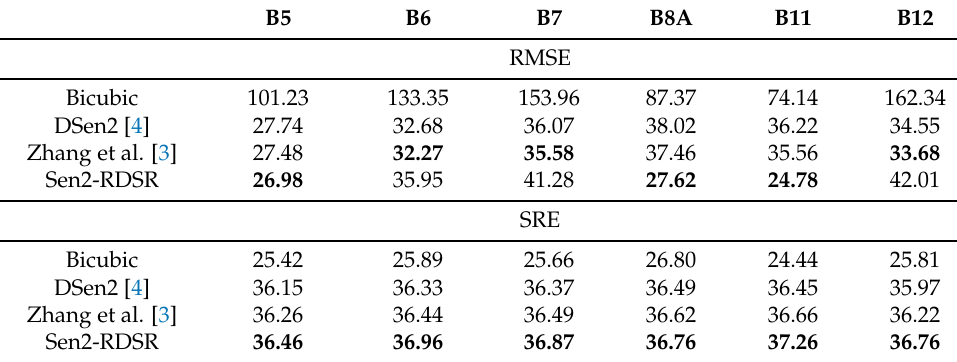
Table 4. Results of the sharpening of 20 m bands (per band).